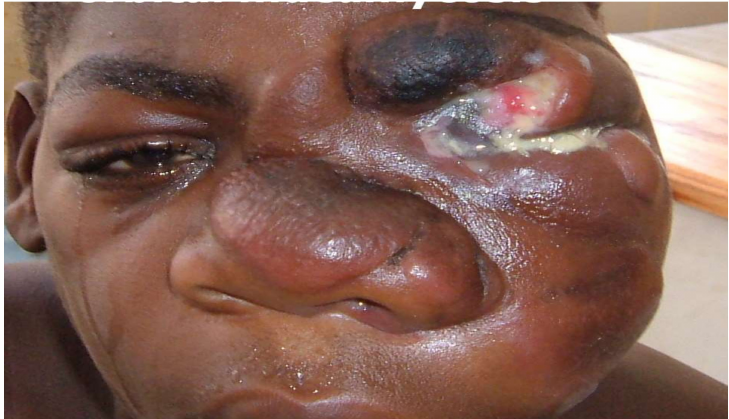
Figure 1. An eye patient presenting at Lions sight first eye hospital in Blantyre Malawi, with a fungal infection (conidiobolomycosis) which has distorted the eye and the overall